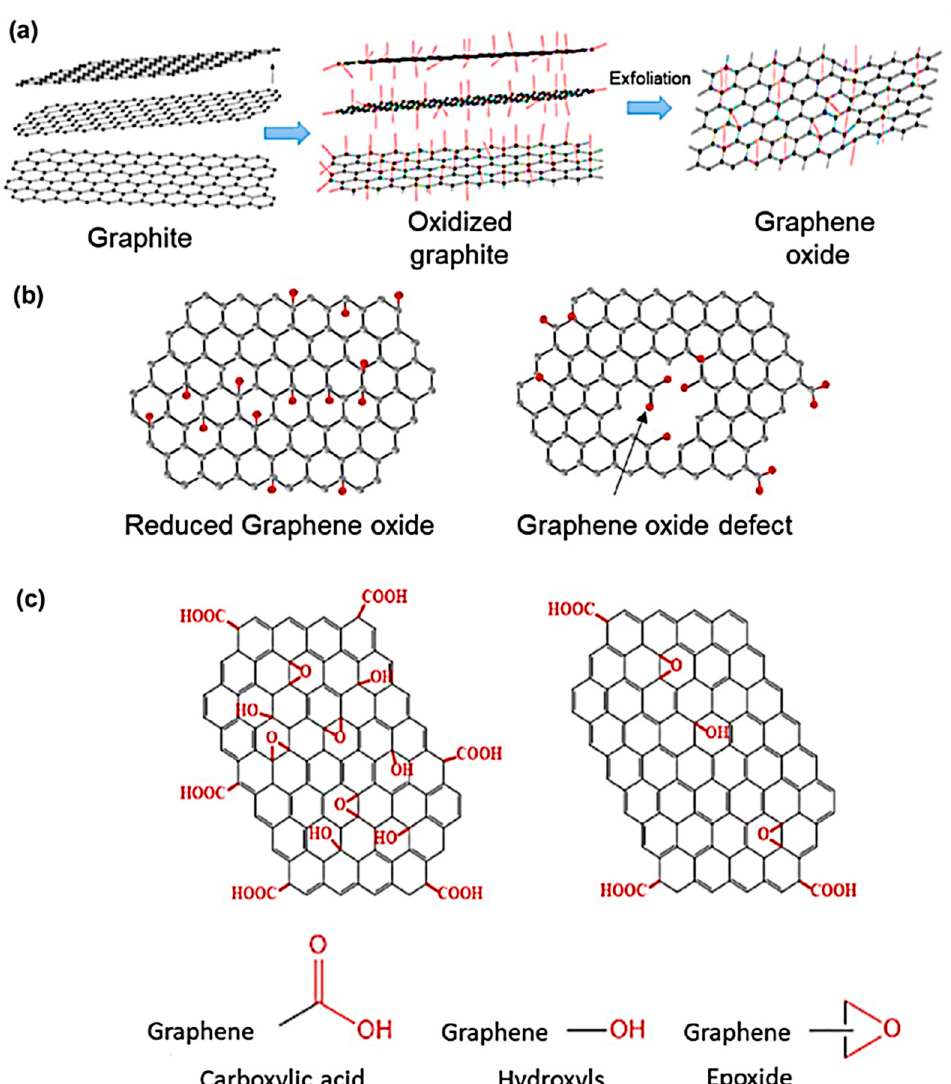
Figure 2. ( a ) Graphene oxide obtained by graphite exfoliation; ( b ) is presented in the reduced graphene oxide structured, as the graphene oxide defect. ( c ) Reactive groups present in graphene oxide and reduced graphene oxide [87]. Reproduced with permission from Springer.